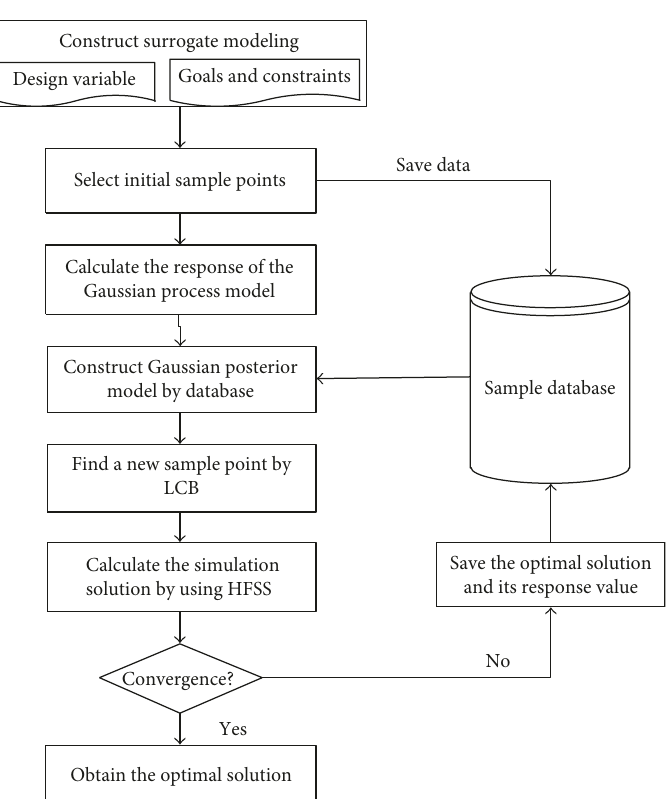
Figure 5: Flowchart of Bayesian optimization